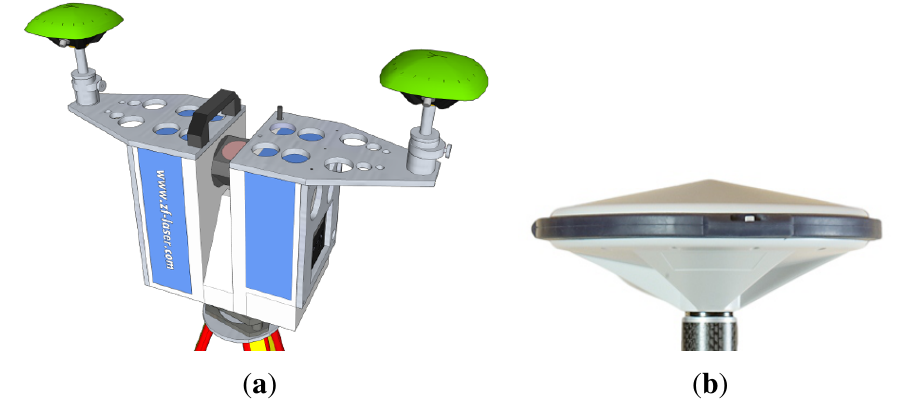
Figure 1. Geo-referencing scenario. ( a ) The MSS formed by a laser scanner (blue) and two eccentrically-mounted GNSS antennas (green) [8]; and ( b ) the reference GNSS station with a known